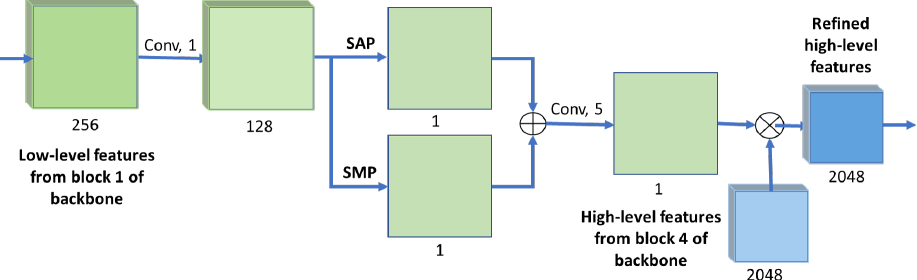
Figure 4. Spatial attention module architecture. The low-level features from the backbone are fed to a 1 × 1 convolution to reduce it to 128 maps. The maps are then fed to both a SAP and SMP layers, with their respective results being added. A final 5 × 5 convolution is used prior to the multiplication with the high-level features from the backbone, resulting in the refined high-level features for GourmetNet. The numbers below each block indicate the number of feature channels.